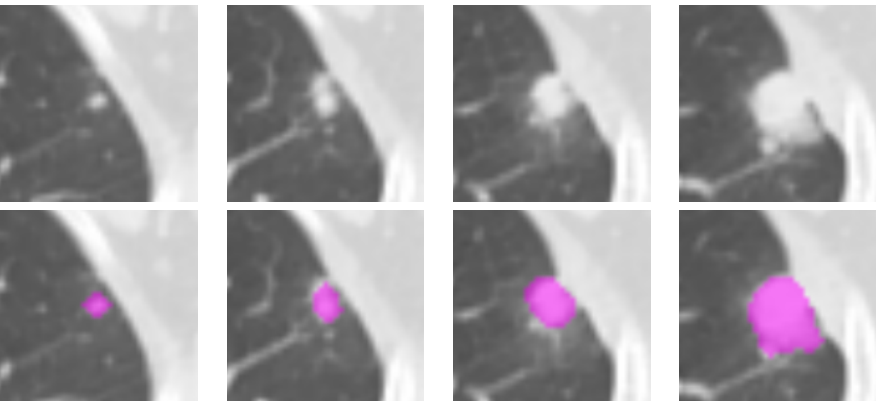
Figure 1. Illustration of the lesion delineation process. The top row shows the cropped areas from contiguous axial slices containing the suspicious lesion; the fuchsia overlays in the bottom row indicate the manually-delineated regions of interest. The lesion in the picture was diagnosed as adenocarcinoma in a 76-year-old man.